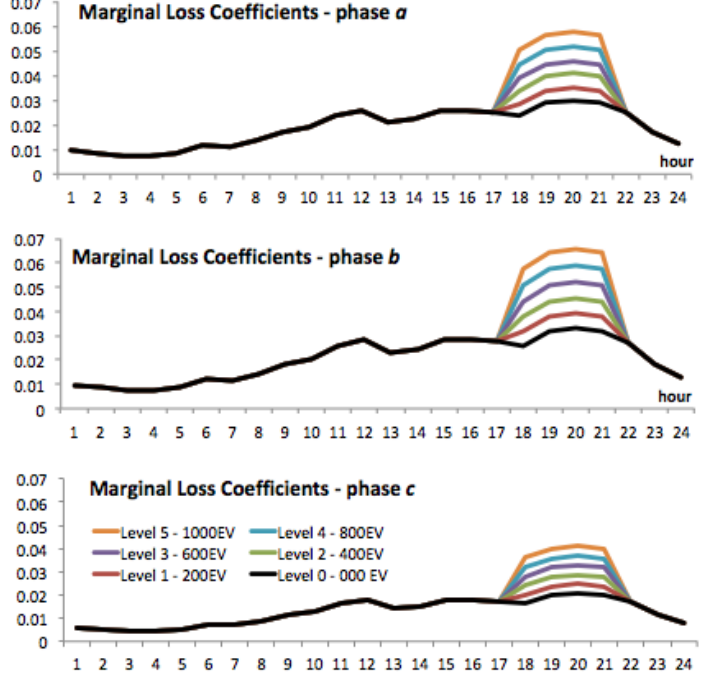
Figure 10. Peak load scenario: MLCs at Bus 21 by EV penetration level and by